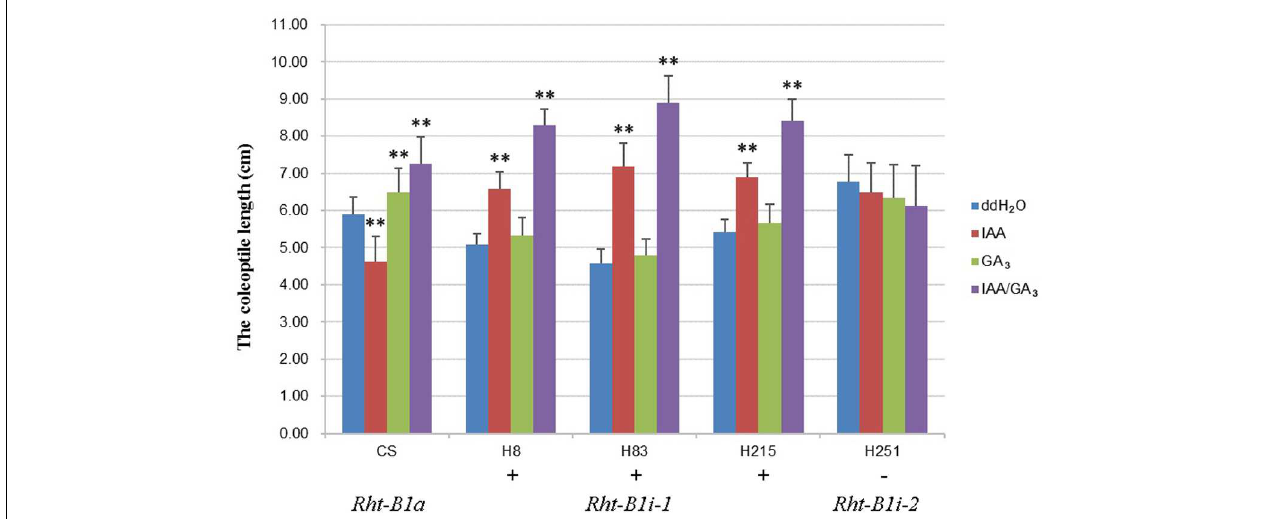
FIGURE 5 | The coleoptile length of wheat varieties with Rht-B1i-1 and Rht-B1i-2. The phyto-hormone treatments of three genotypes, Rht-B1a , Rht-B1i-1 , and Rht-B1i-2, with ddH 2 O as a control. ∗∗ Denote significant differences at the 1% probability level. + , – Denote Rht-B1i-1 containing the 160 bp insertion and Rht-B1i-2 missing the 160 bp insertion,